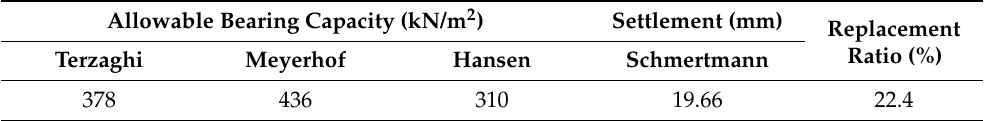
Table 5. Specification of the DCM foundation method (Allowable bearing capacity and